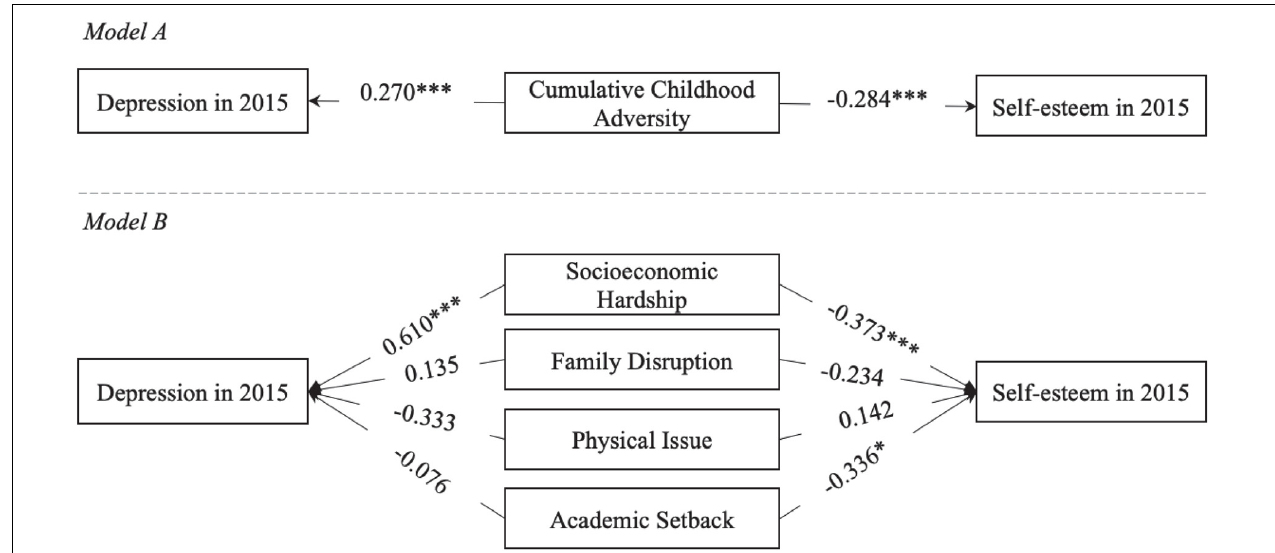
FIGURE 4 | Illustration of the associations between childhood adversity and childhood mental health in adulthood. Age and gender are not shown in this figure for simplicity. Numbers on arrows are unstandardized regression coefficients. ∗ < 0.05, ∗∗ < 0.01, ∗∗∗ <